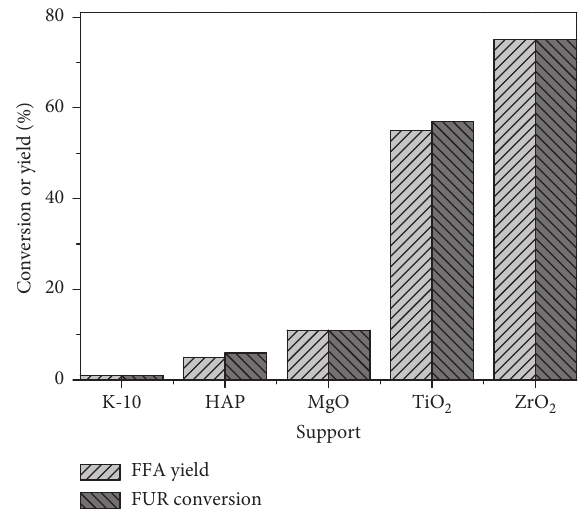
Figure 2: Effect of different supports on the synthesis of FFA from FUR. Reaction conditions: 0.5mmol FUR, 25mg catalyst, 2.5 equiv. H − of PMHS, 2mL DMF, 25 ° C, and 30min. K-10: montmorillonite K-10; HAP: hydroxyapatite microspheres; MgO: nanomagnesium oxide; TiO 2 : nanotitanium dioxide; ZrO 2 : zirconium oxide nanopowder.